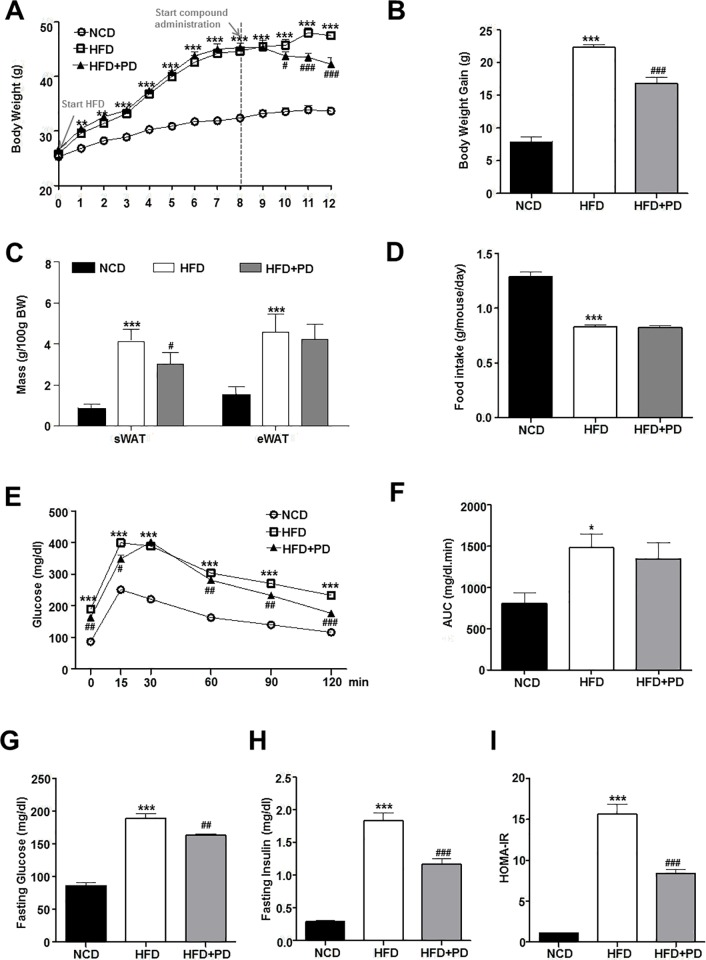
Effect of epidermal growth factor receptor (EGFR) inhibition on metabolic phenotypes in high fat diet (HFD)-fed mice.(A) Body weight. (B) Body weight gain. (C) Subcutaneous and epididymal fat mass (g/100 g body weight). (D) Food intake (g/day/mouse). (E) Glucose tolerance test (GTT); glucose (1 g/kg body weight) was injected into overnight-fasted mice. (F) Area under the curve (AUC) for GTT. (G) Fasting blood glucose levels. (H) Fasting blood insulin levels. (I) Homeostasis model of assessment for insulin resistance index (HOMA-IR) assessed as fasting insulin (μU/mL) × fasting glucose (mg/dL)/22.5. NCD, normal chow diet (NCD)-fed mice (NCD, black bars or white circles); HFD, untreated HFD-fed mice (white bars or white squares); HFD+PD, HFD-fed mice treated with PD153035 (gray bars or black triangles). Data are expressed as the mean ± standard error of the mean (SEM). * P < 0.05, ** P < 0.001, *** P < 0.0001 NCD vs. HFD group. # P < 0.05, ## P < 0.001, ### P < 0.0001 HFD vs. HFD+PD group.